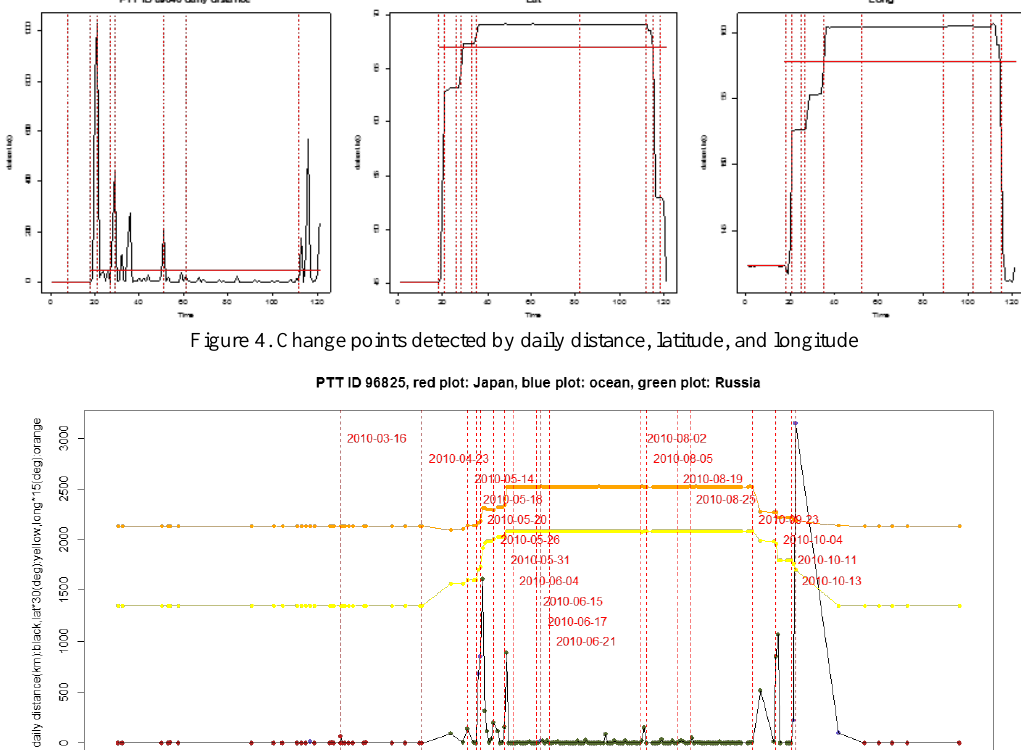
Figure 5 (a). Visualization of change points